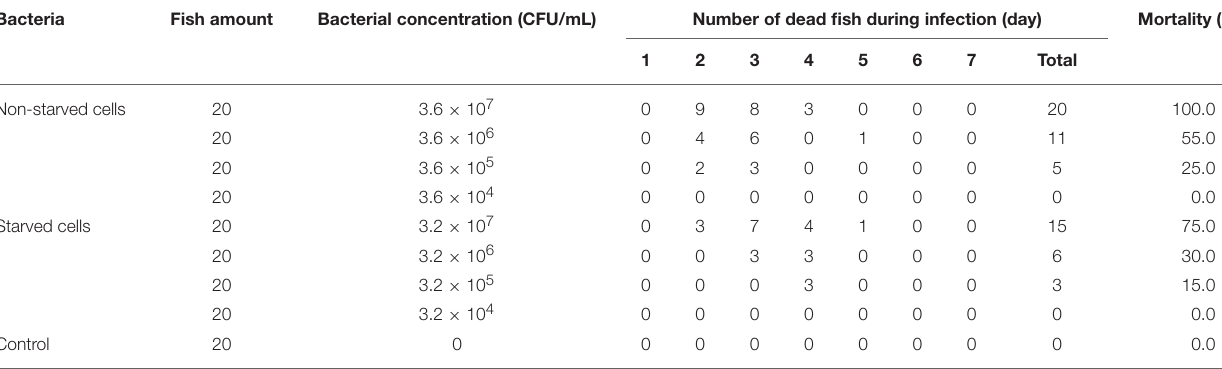
Data are presented as average value of three repeats at each concentration.